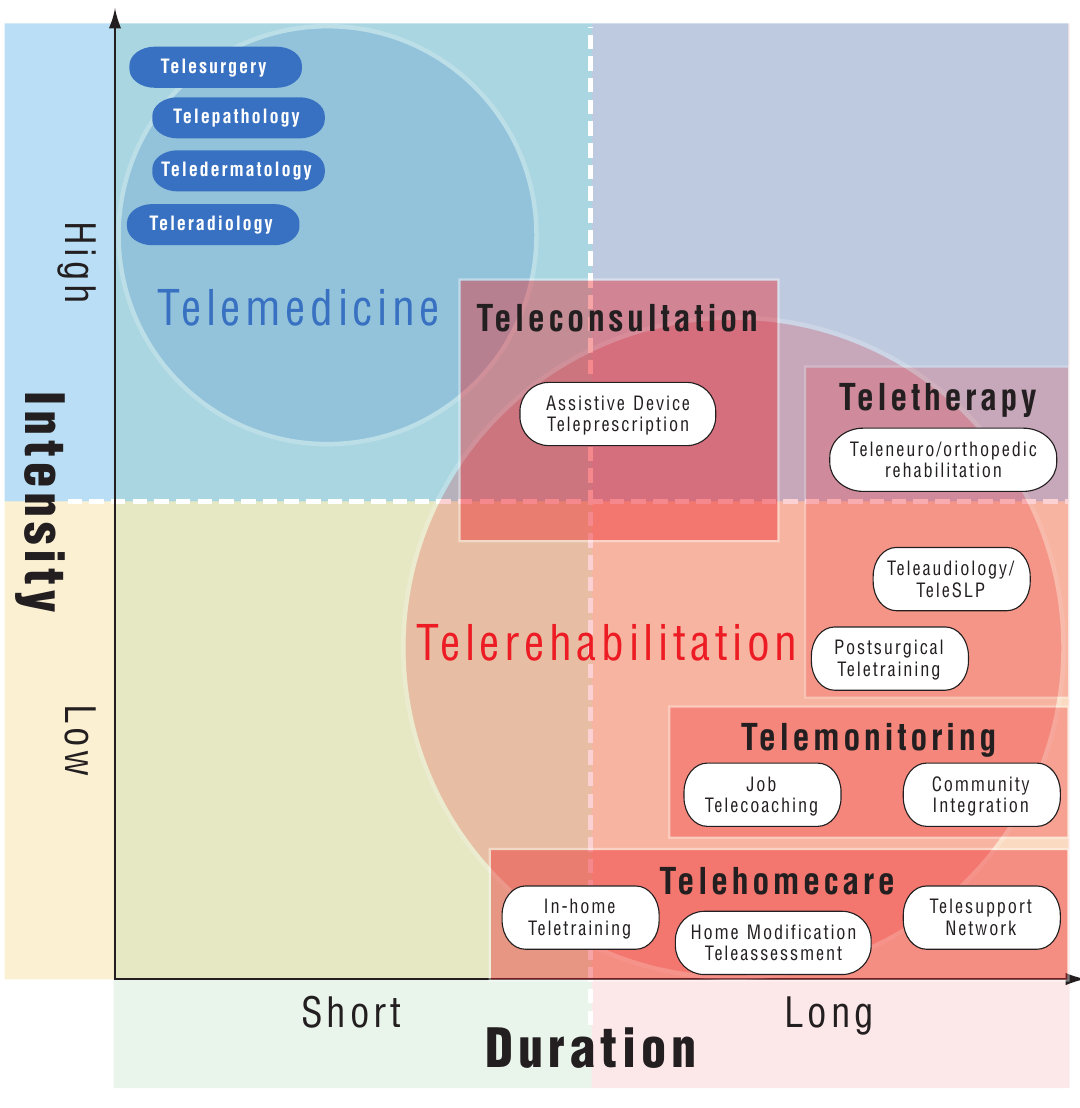
Figure 1. Map of telemedicine services in Intensity-Duration quadrant model Telerehabilitation shares many features of chronic disease management. In chronic disease management, periods of time. Similarly, the client in